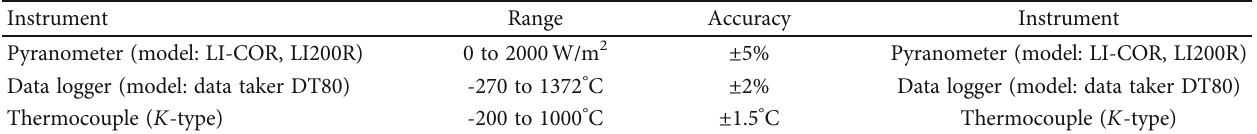
Table 1: Measuring ranges and